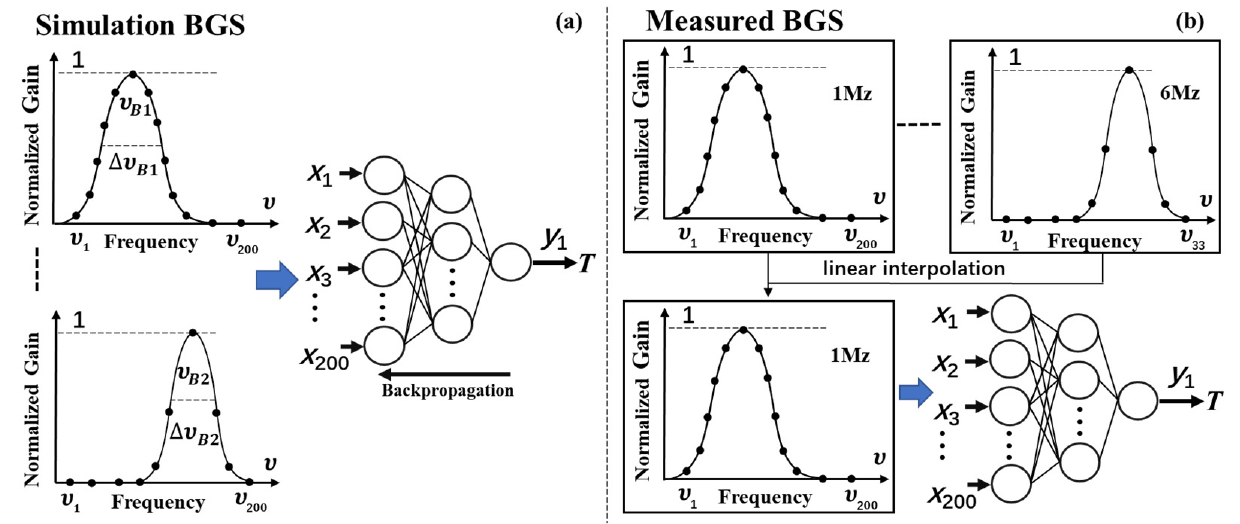
Figure 8. Training ( a ) and testing ( b ) schematic of the FNN. When the normalized raw BGS image with a scanning frequency interval of 1 MHz is input to the FNN module, temperature information can be achieved in less than 17 s, as shown in Figure 9a. The results indicate that the extracted temperature fluctuates within a range of ± 10 ◦ C around room temperature, and the jump in the temperature transition region is clearly observed. When the input data of the FNN module result from using the QWT denoising technique, the temperature distribution can be attained in less than 17 s, and is shown in Figure 9b. The results indicate that the extracted temperature fluctuates within ± 0.11 ◦ C of the actual temperatures, 44, 55, 64 and 75 ◦ C, which is in good agreement with the actual temperature exerted in the last 200 m fiber under test. The spatial resolution is determined as 3 m, which is consistent with the time domain width of a 15 ns pump pulse. For convenience in comparison, the temperature distribution extracted from the same data set by LCF is shown in Figure 9c. The results show that the measured temperature error maintains within ± 2.5 ◦ C for the later 200 m FUT. Notably, the initial parameters of peak point frequency and FWHM for the LCF are chosen by the BGS data at the front of the FUT. The reason for the ± 2.5 ◦ C error is that the matching parameters for LCF cannot be adjusted dynamically. Moreover, the time consumed by the QWT algorithm’s processes of denoising, normalization, linear interpolation, and temperature extraction from the FNN is less than 20 s, while for the LCF, it takes 11 m to obtain poor results. In the case of the scanning interval, no more than 6 MHz after the QWT’s denoising, normalization and linear interpolation, the BGS is input to the FNN module. The experiment data are collected at 2, 4, and 6 MHz intervals and a 200 MHz sampling rate. The room temperature is about 25 ◦ C, and in the heat section of the FUT is 55 ◦ C. In the transition zone, all the temperature data from the FNN fit those from the raw data completely. In addition, when the scanning interval is less than 6 MHz, the temperature error is about ± 0.15 ◦ C, which not only meets the requirements of many large infrastructures for measurement accuracy, but also can limit the time of information extraction to within 20